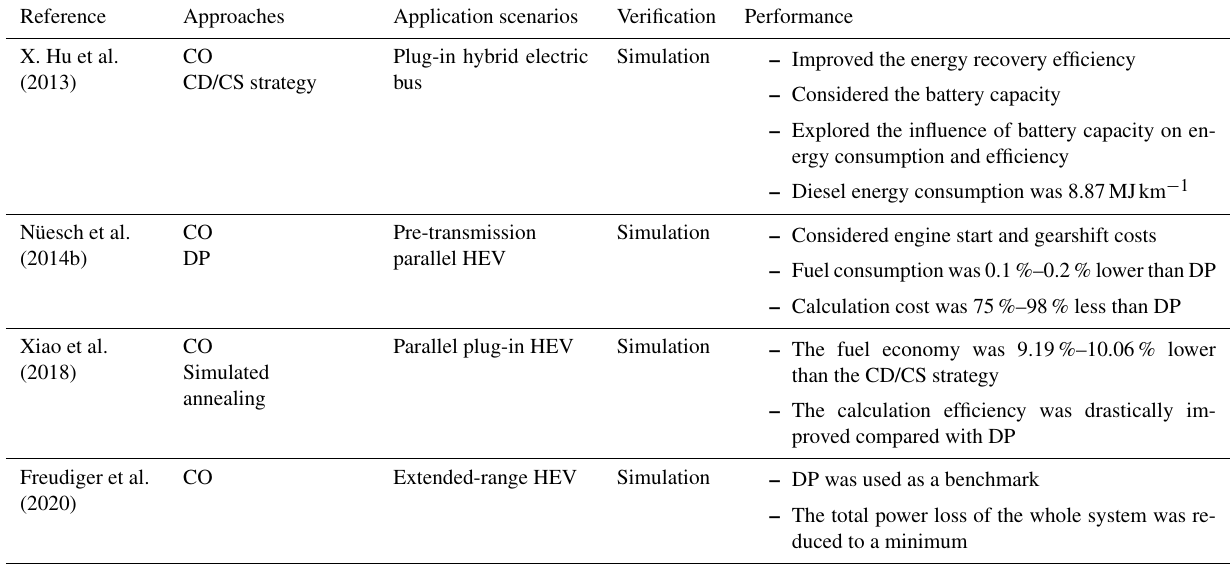
Table 9. Summary of exemplary works on CO-based EMSs.